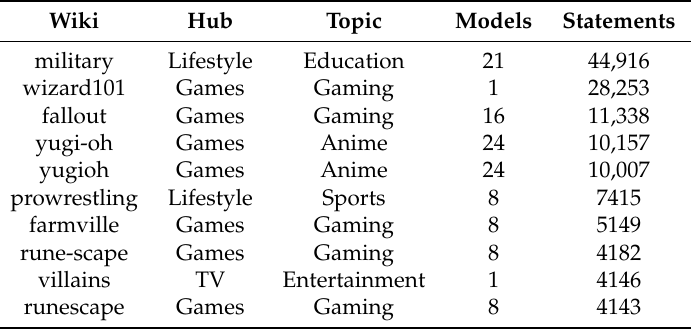
Table 10. The 10 Wikis from which most statements could be extracted.